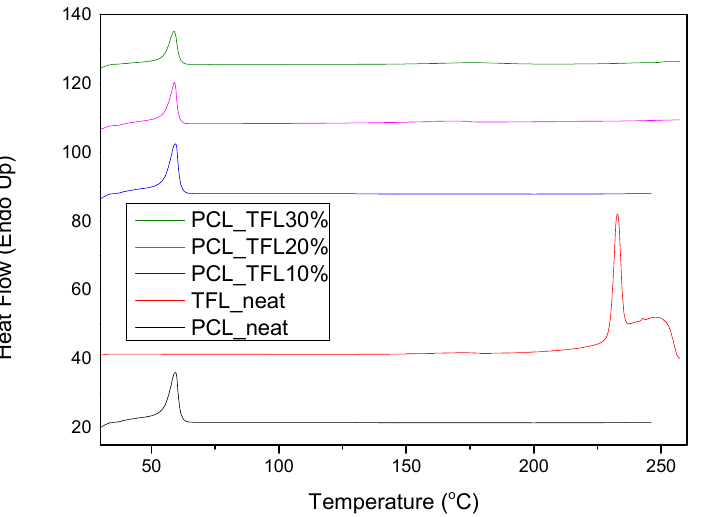
Figure 7. DSC the rmograms of PCL neat, teriflunomide neat and drug-loaded fibrous mats.